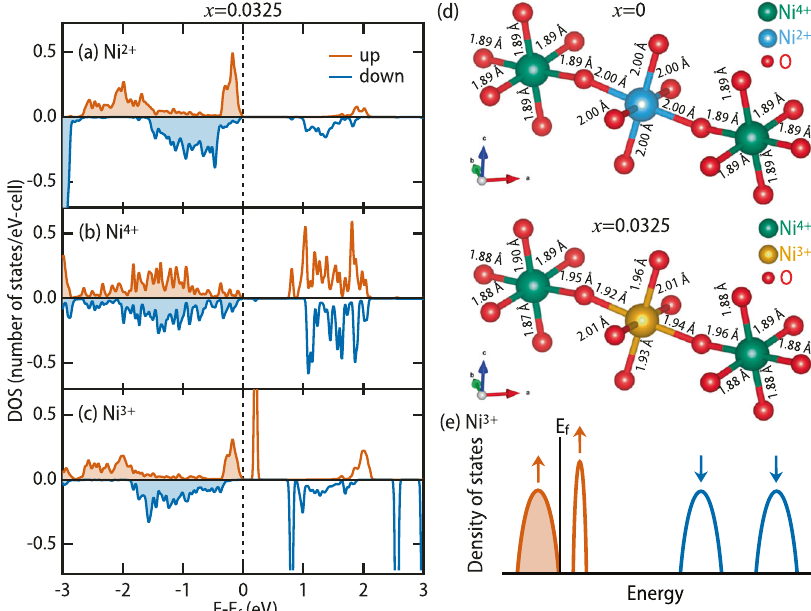
Fig. 2 Ab initio calculations. a – c Calculated spin resolved density of states of Ni 2 + , Ni 4 + , and Ni 3 + , respectively for x = 0.0325. d Ni – O bond lengths for x = 0 and x = 0.0325, respectively. The doped hole is going to one of the Ni 2 + sites around the Ca dopant, converting it to Ni 3 + (see Supplementary Note 4 for full relaxed structures). e Schematic of density of states of Ni 3 + of x =